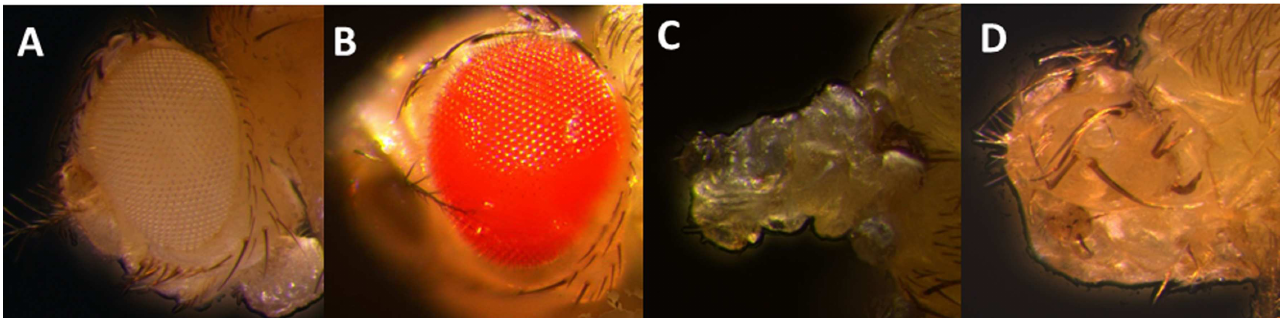
Fig 8. Eye phenotypecaused by expressionof RpPax6 is partially rescuedby inhibitionof apoptosis(A, B) head of y w and UAS-RpPax6 pharate. (C) UAS-RpPax6/ey-GAL4 pharate with most head structures and both eyes absent. (D) UAS-RpPax6/ey-GAL4 pharate headlessphenotype can be largelyrescued by coexpressionof p35, an inhibitor of